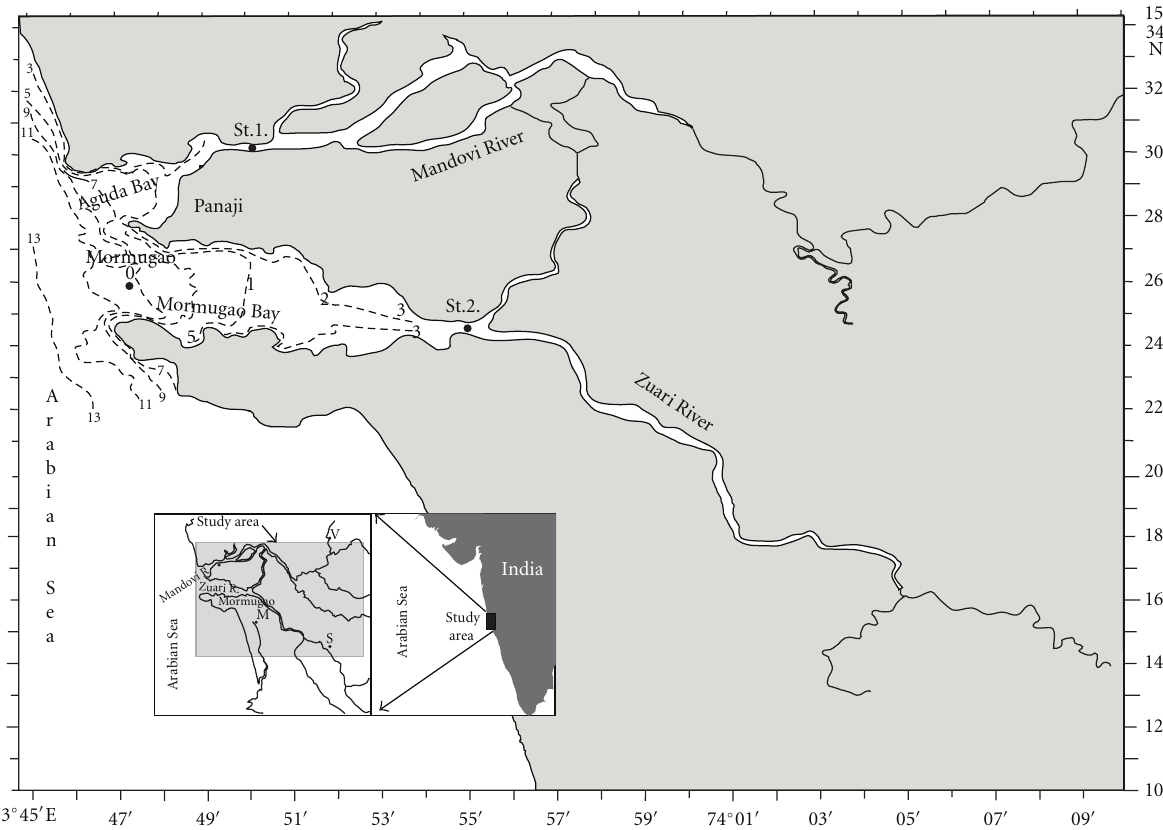
Figure 1: Map showing sampling stations (St.1-Mandovi and St.2-Zuari) estuaries of